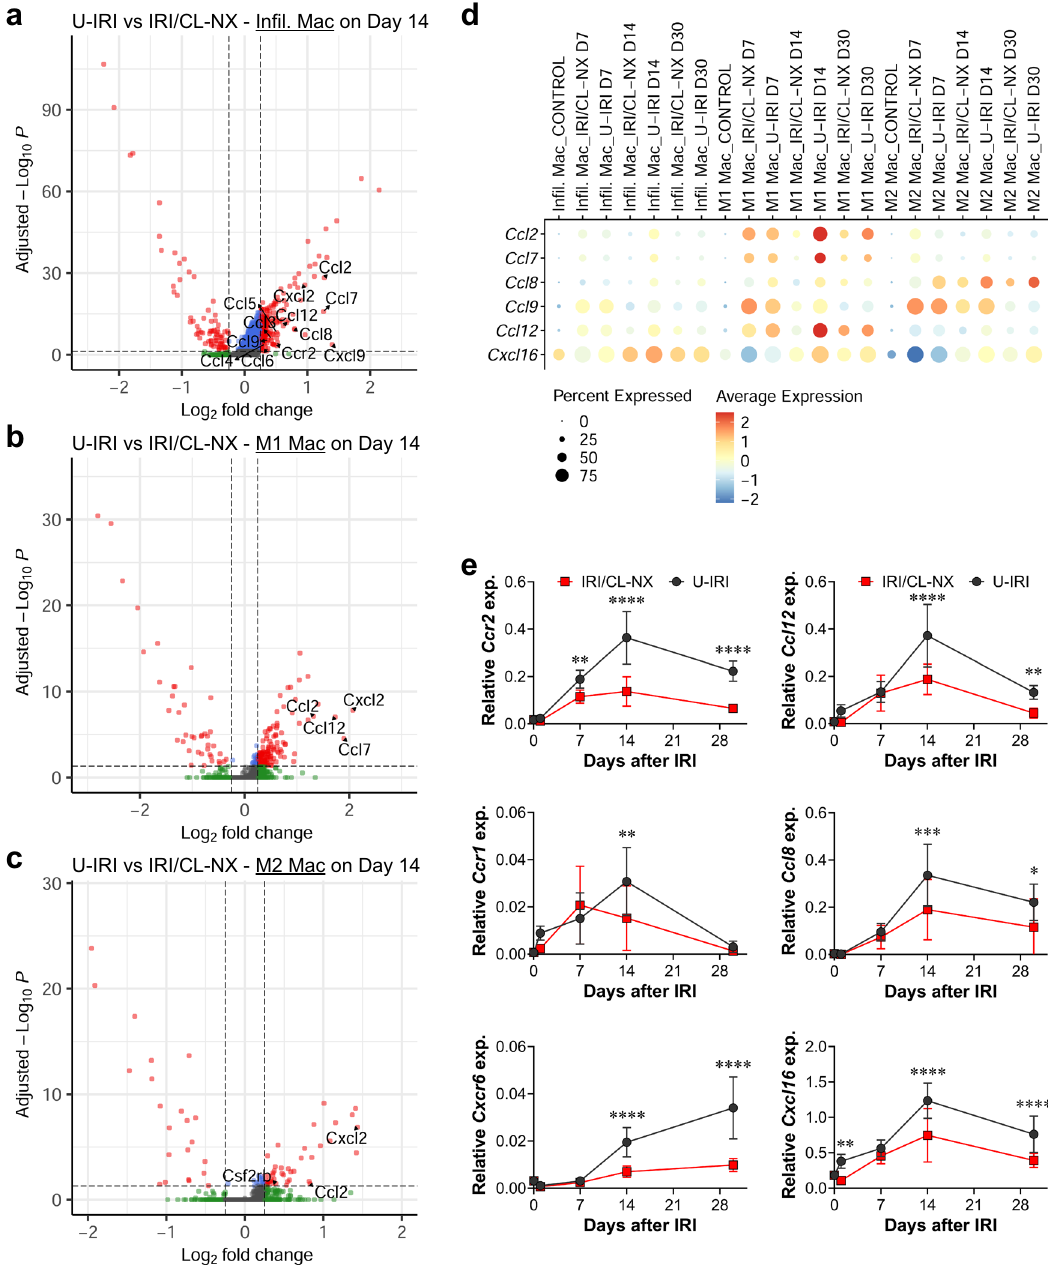
Fig.5|U-IRIpromotesincreasedchemokineexpression2weeksafterIRI. Wild- type mice were subjected to 27min of ischemia/reperfusion injury (IRI) with con- tralateral nephrectomy (IRI/CL-NX) or unilateral IRI (U-IRI) and sacri fi ced on day